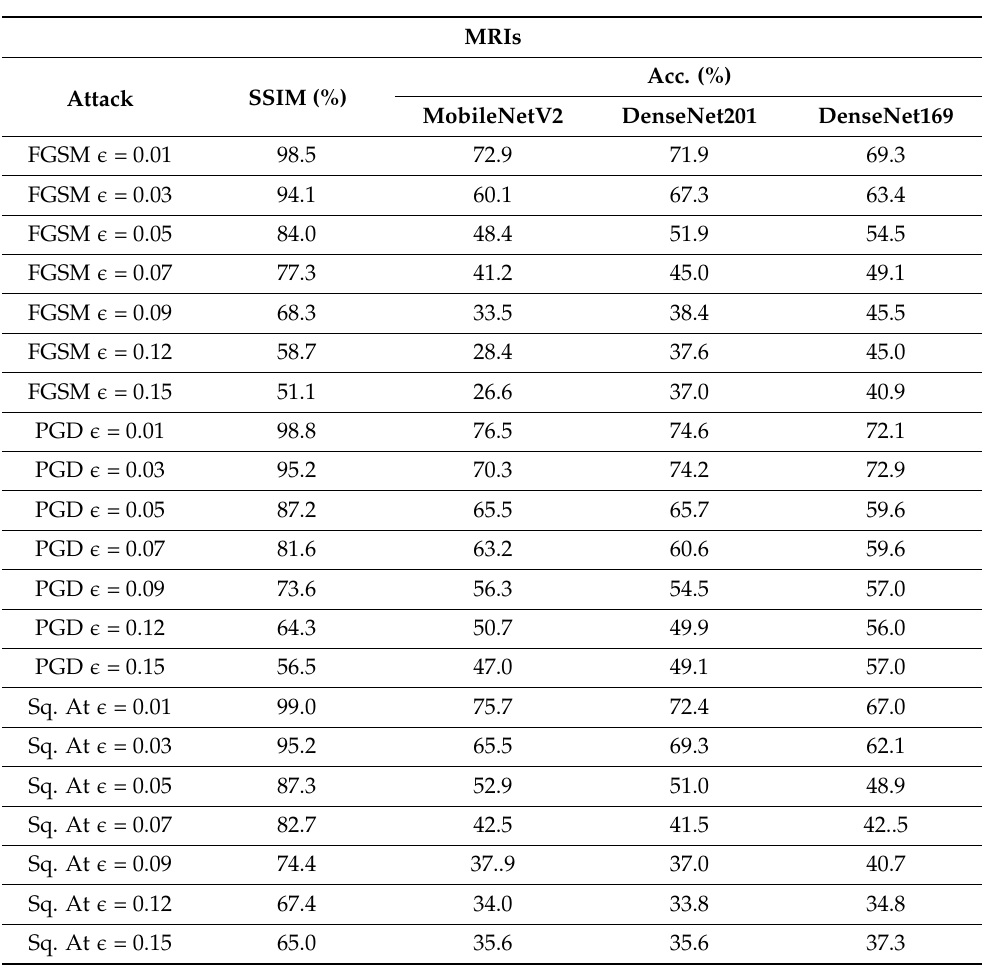
Table A8. SSIM index and performance for each attack in MRIs.